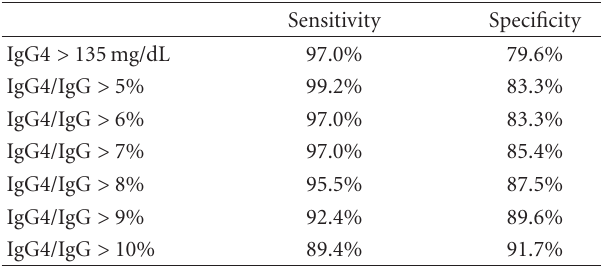
Table 3: Sensitivity and specificity of serum cuto ff values in the diagnosis of